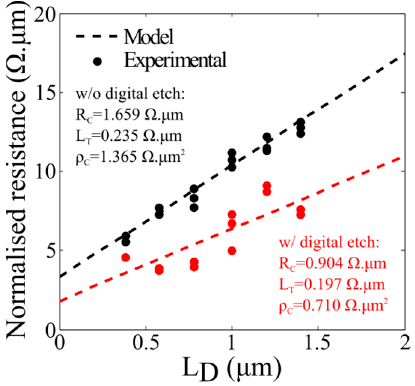
Figure 2. Variation of normalized resistance as a function of contact spacing L D .